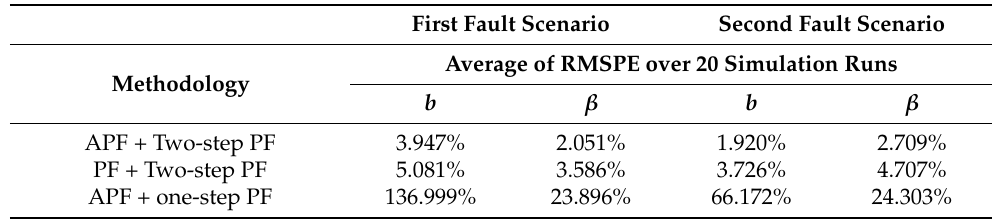
Table 6. Performance comparison for degradation model estimation evaluation.